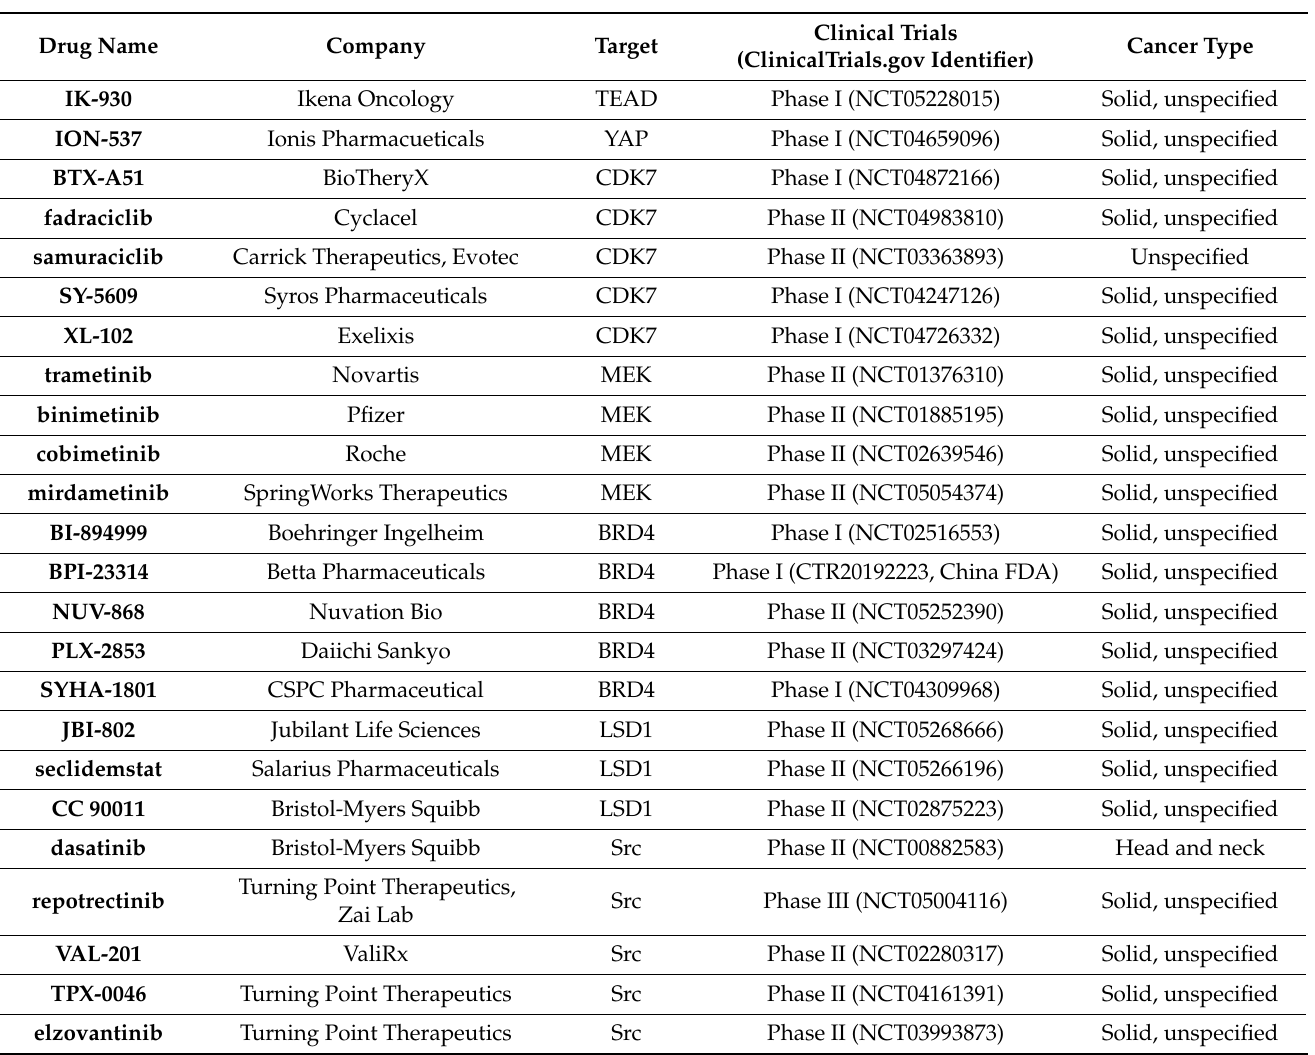
Table 1. Representative potential drugs targeting the Hippo pathway undergoing clinical trials. Potential drugs undergoing clinical trials were searched using “head and neck cancer” or “solid, un- specified” terms using the Pharmaprojects intuitive interface of Citeline. Drugs shown as “Preclinical” were